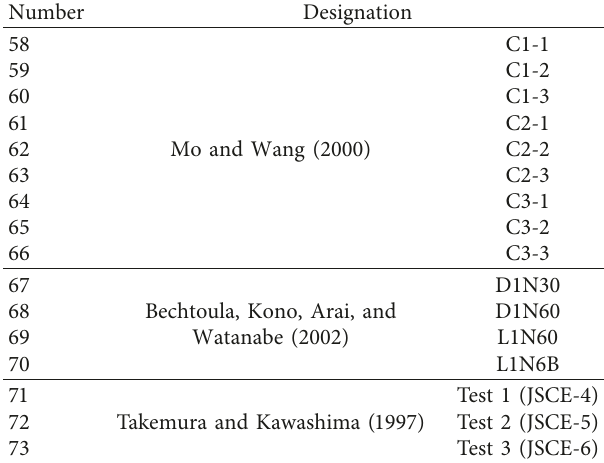
Table 1: Selected columns with square cross section from the PEER database